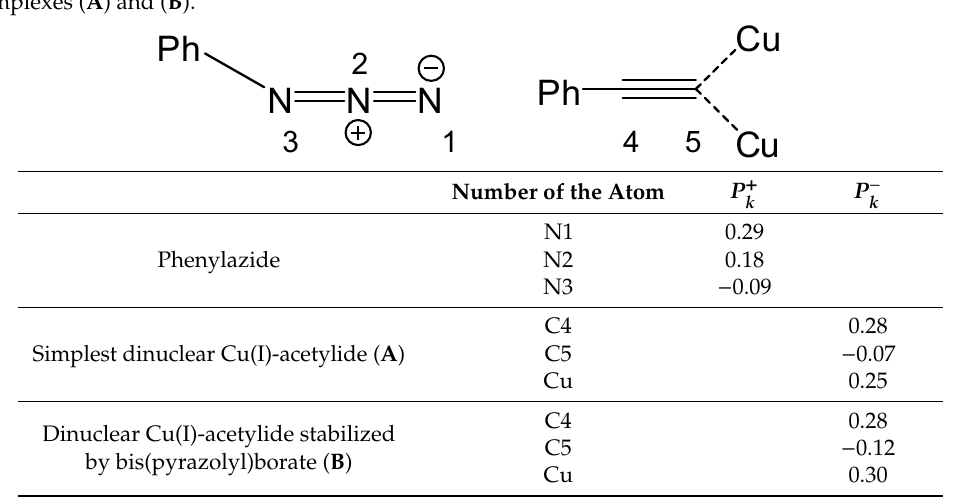
+ P Parr functions of the phenylazide and nucleophilic − k Parr functions of the phenylazide and nucleophilic P − k